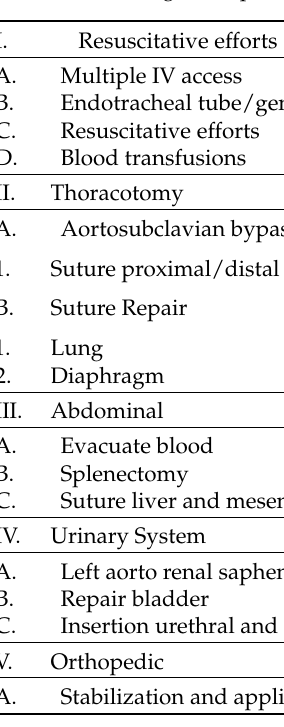
Figure 1. Post Bypass Aortic Anatomy Schematic Drawing. Table 2. Initial Surgical (Operating Room)